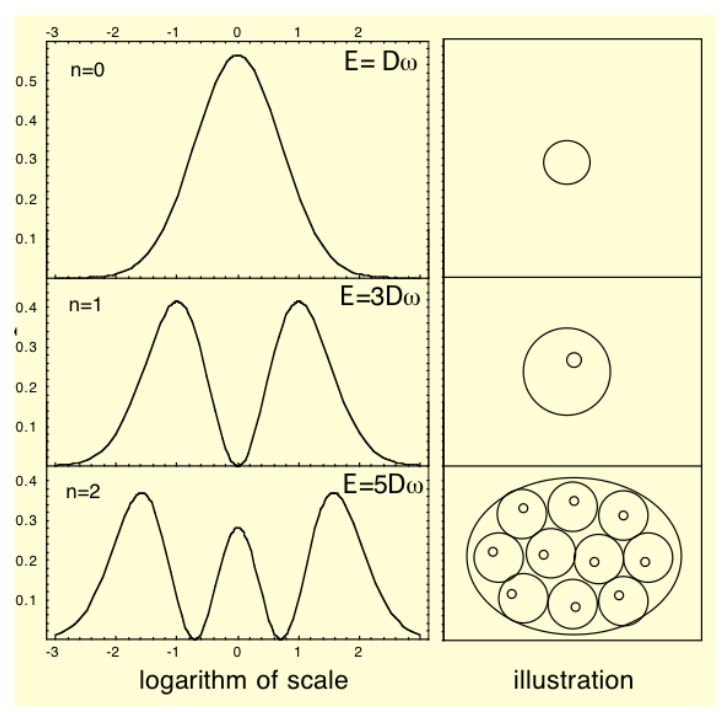
Schematic illustration of a model of hierarchical organization based on a Schr ¨ odinger equation acting in scale space. The fundamental mode corresponds to only one level of hierarchy, while the first and second excited modes describe respectively two, then three embedded hierarchical